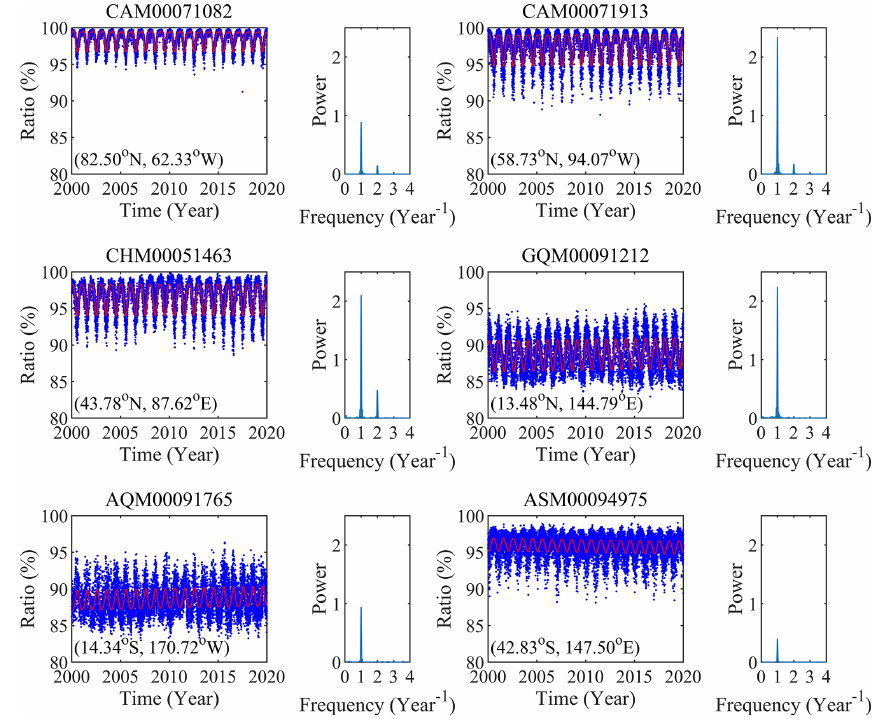
Figure 2. Time series of the ratio of the ZHD to ZTD at six radiosonde stations located in different latitude regions.